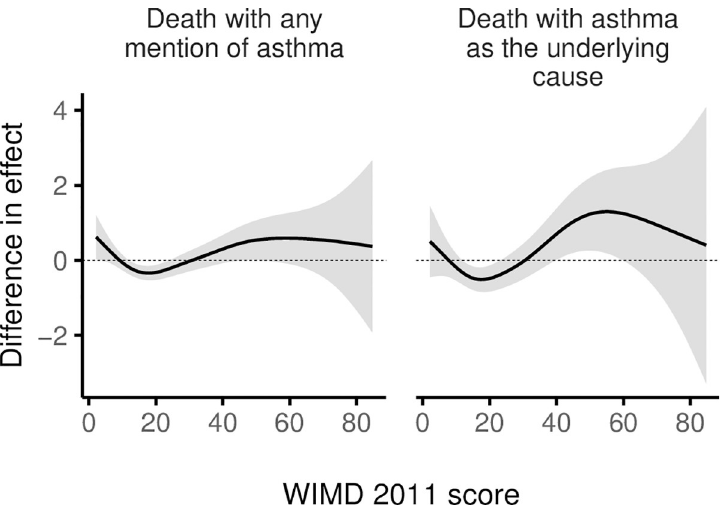
Fig 12. Difference smooths from GAMs showing a varying gender gap in the effect of WIMD 2011 score on asthma deaths. The shaded area represents the 95% CI of difference in effect. A positive difference means a higher effect in females than males. CI, confidence interval; GAM, generalised additive model; WIMD, Welsh Index of Multiple Deprivation.